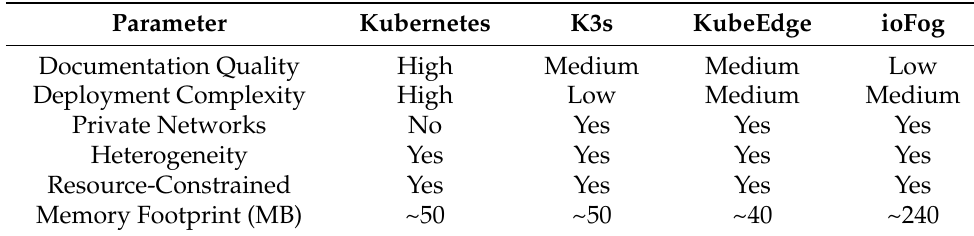
Table 3. Cluster deployment